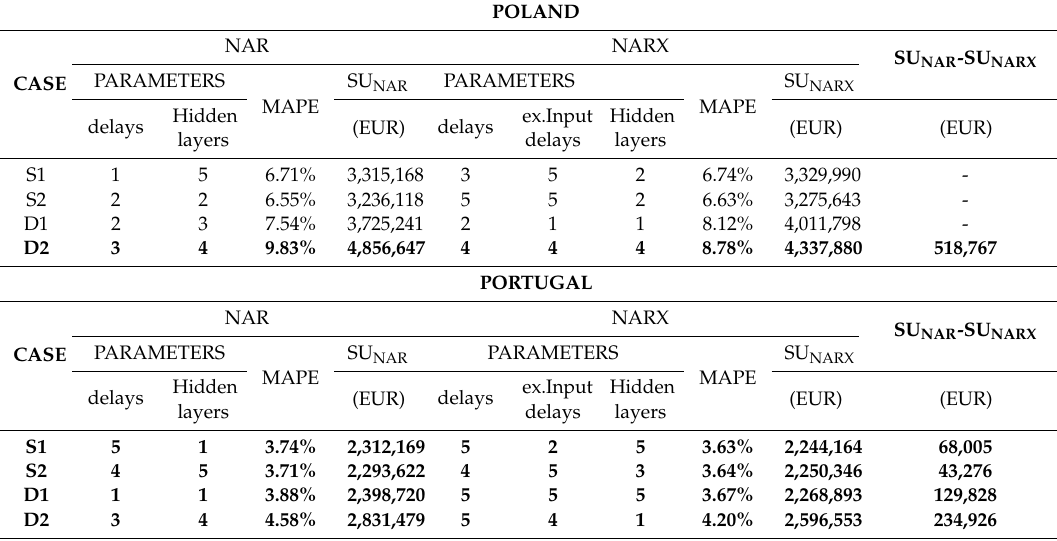
Table 6. Comparison of the non-linear auto-regressive neural network (NAR) and NAR with exogenous inputs (NARX) spot prices forecasting